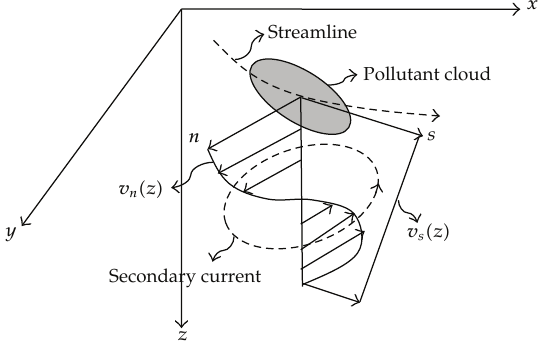
Figure 2: Schematic diagram for SSFD model: v s ,v n : horizontal velocities on the s,n axes; z : coordinate axis of the vertical